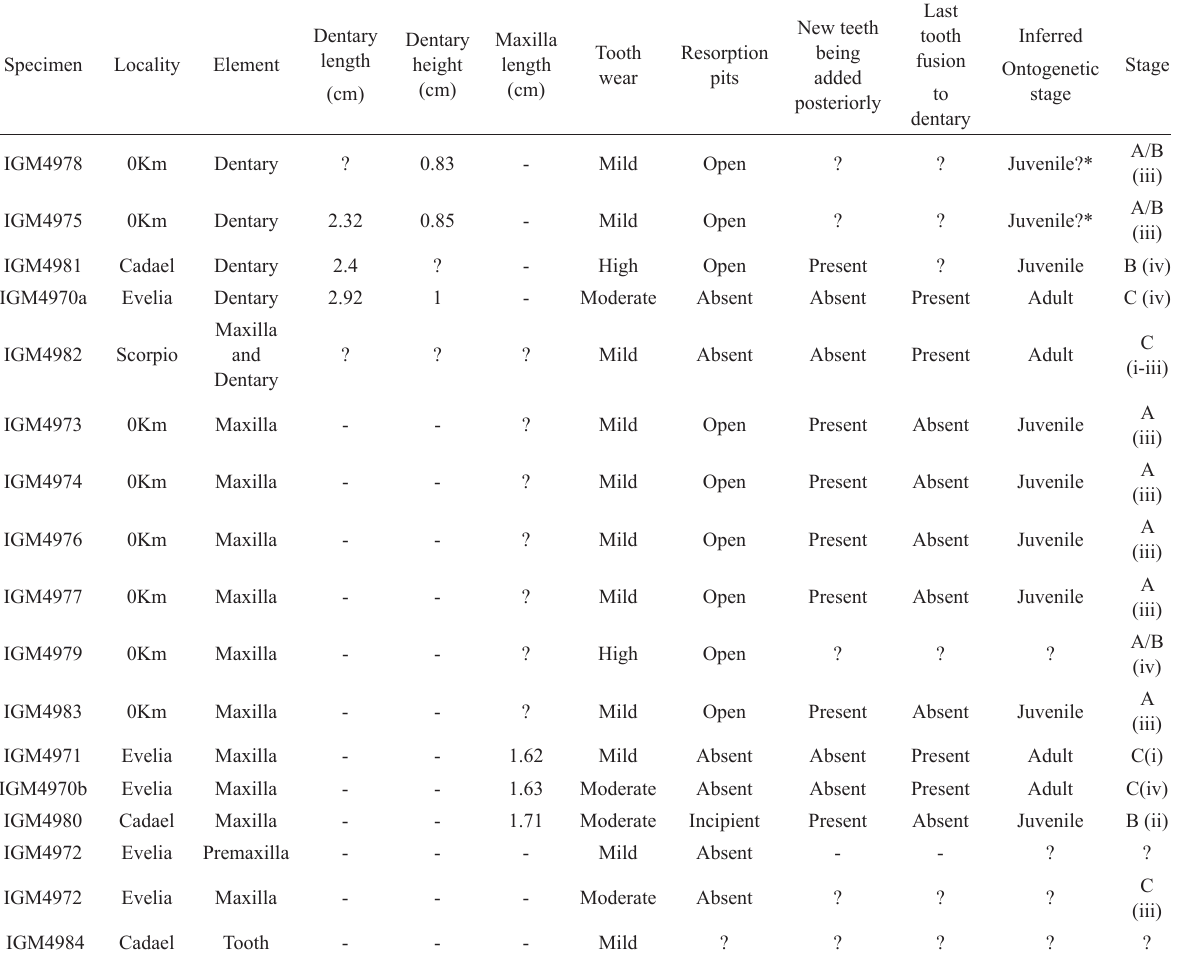
Individual specimens and ontogenetic